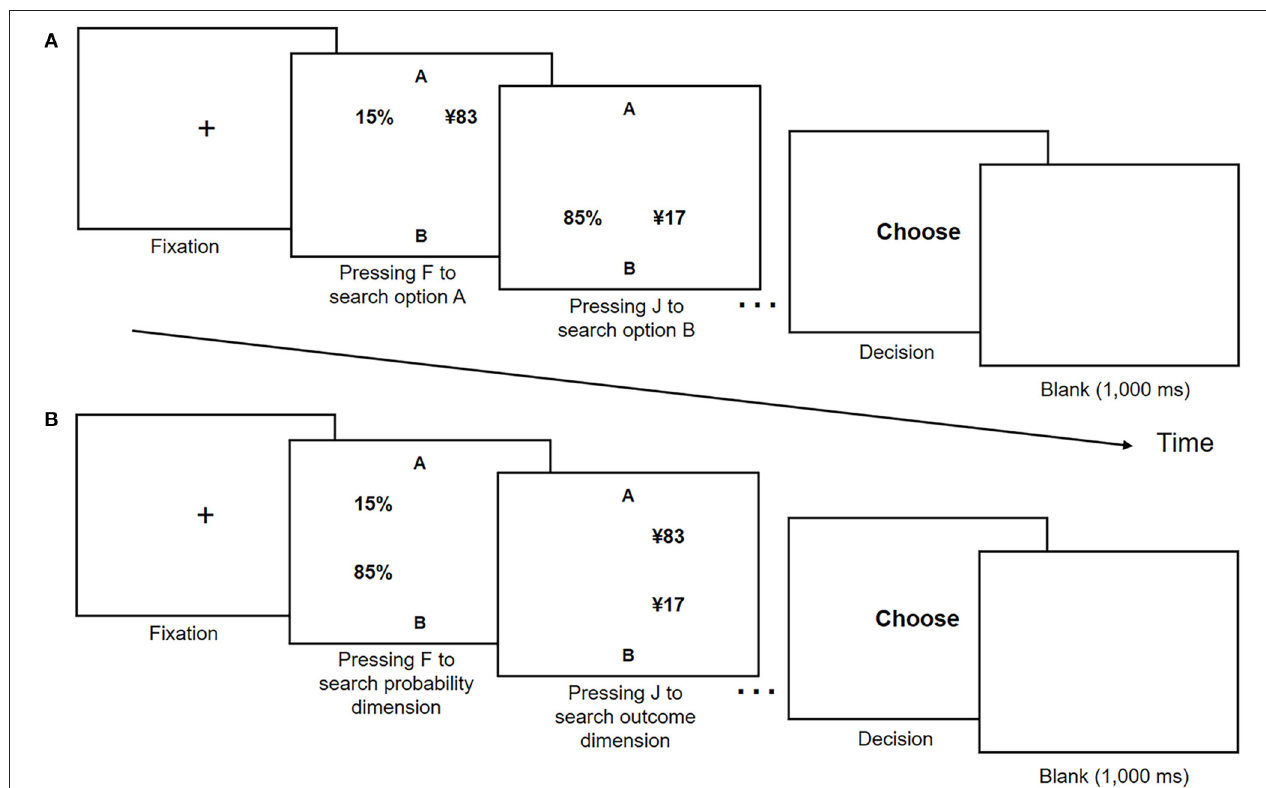
FIGURE 1 | Trial procedure and timing in (A) alternative- and (B) dimension-wise tasks in Experiment